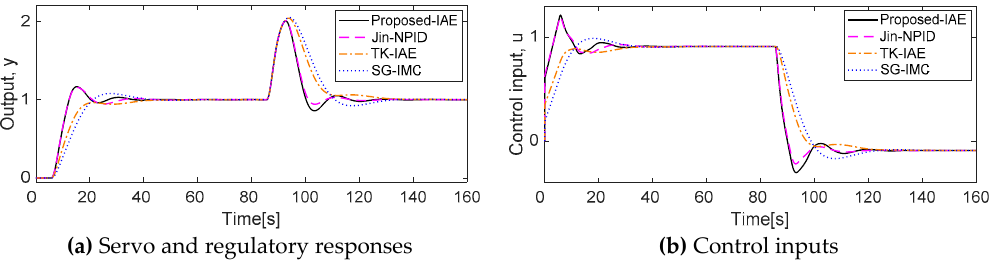
Figure 12. Servo and regulatory responses for process 3 under 10% mismatch. Table 9. Quantitative comparison of performances for process 3 under 10%